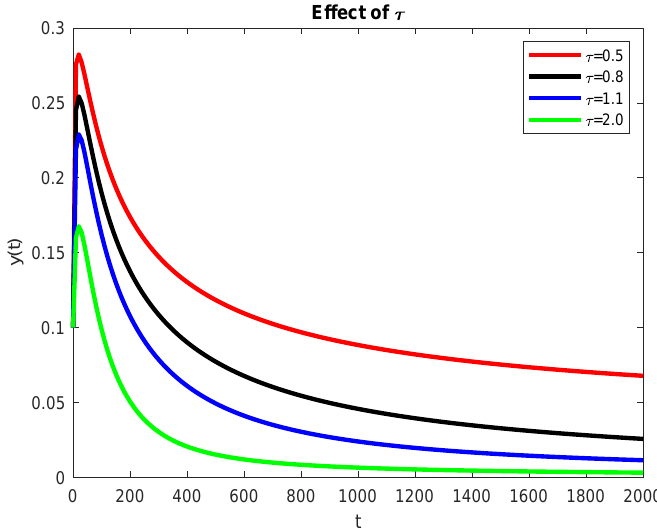
Figure 3. Graph of the effect of τ on y ( t ) in the endemic case, as considered in Table 1. We used the delayed values provided in the legend of the graph and set a differentiation order equal to 0.9. To carry out the simulations, we used the numerical model presented in this work in order to approximate the solutions for the epidemic model under